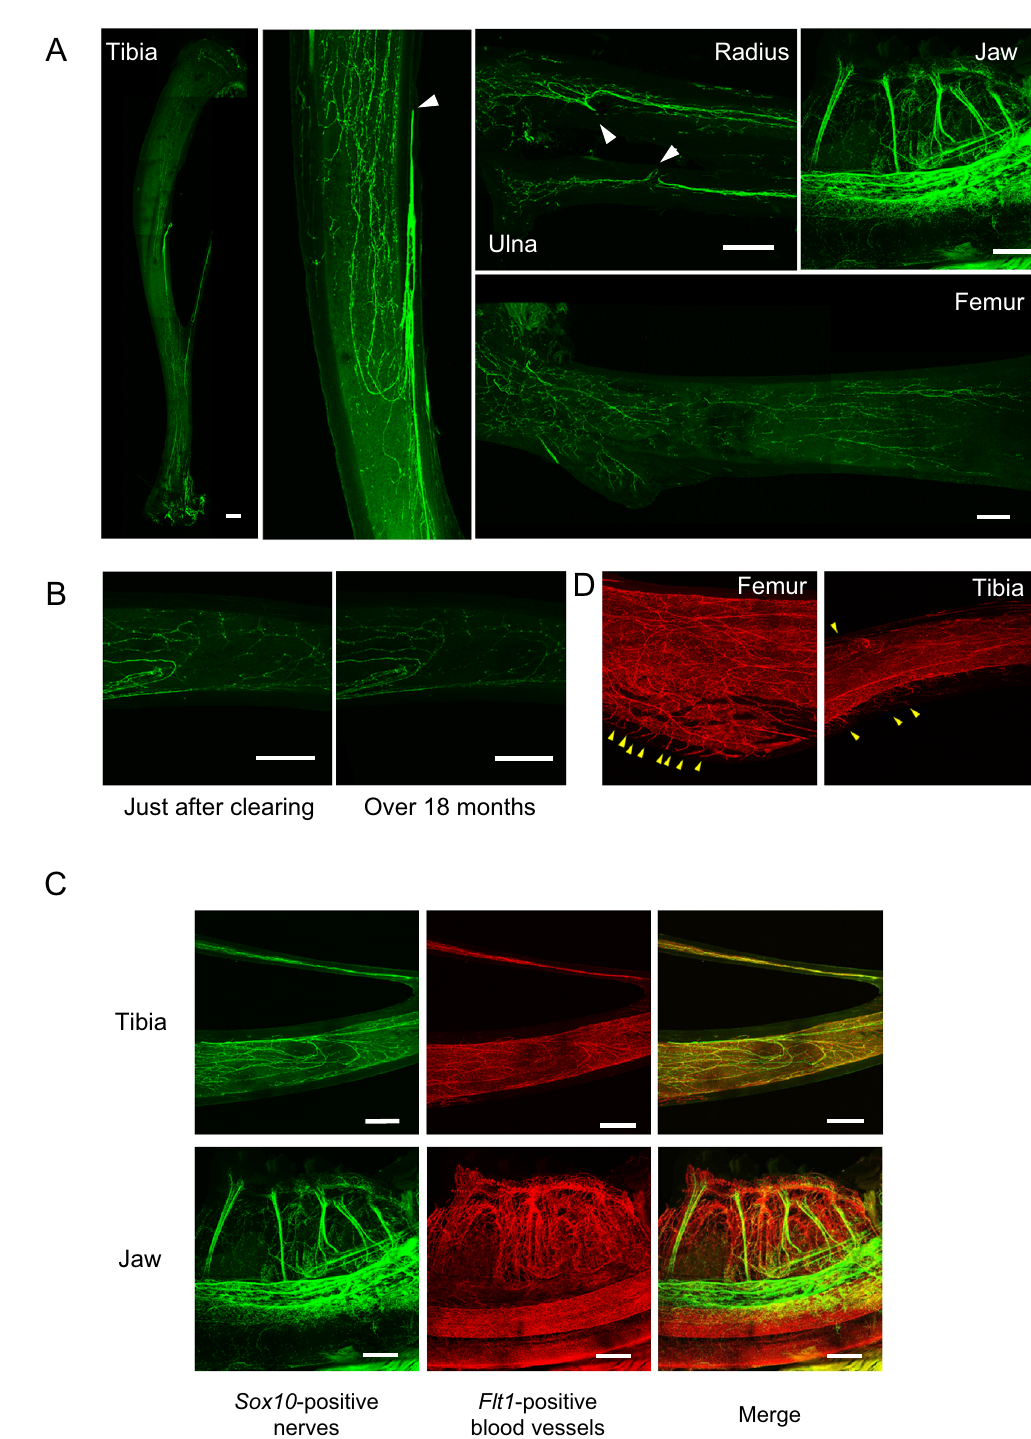
Figure 2. The newly established optical bone clearing (Osteo-DISCO) method reveals the 3D structure of the neurovascular network inside bone. ( A ) Visualized nerves inside bones of Sox10-venus mice (tibia: the whole and magnified midshaft, forearm: radius and ulna, jaw, and femur). White arrowhead: Specific entry site of Sox10 -positive nerves. Scale bar: 500 µm. ( B ) Venus fluorescence of Sox10 -positive nerves was preserved even 18 months after clearing. Scale bar: 500 µm. ( C ) Visualized nerves and blood vessels inside bones of Sox10- Venus; Flt1-tdsRed mice (tibia and jaw). Scale bar: 500 µm. ( D ) Blood vessels entering bone tissue in Flt1-tdsRed mice. Yellow arrowheads: entry sites of Flt1 -positive blood